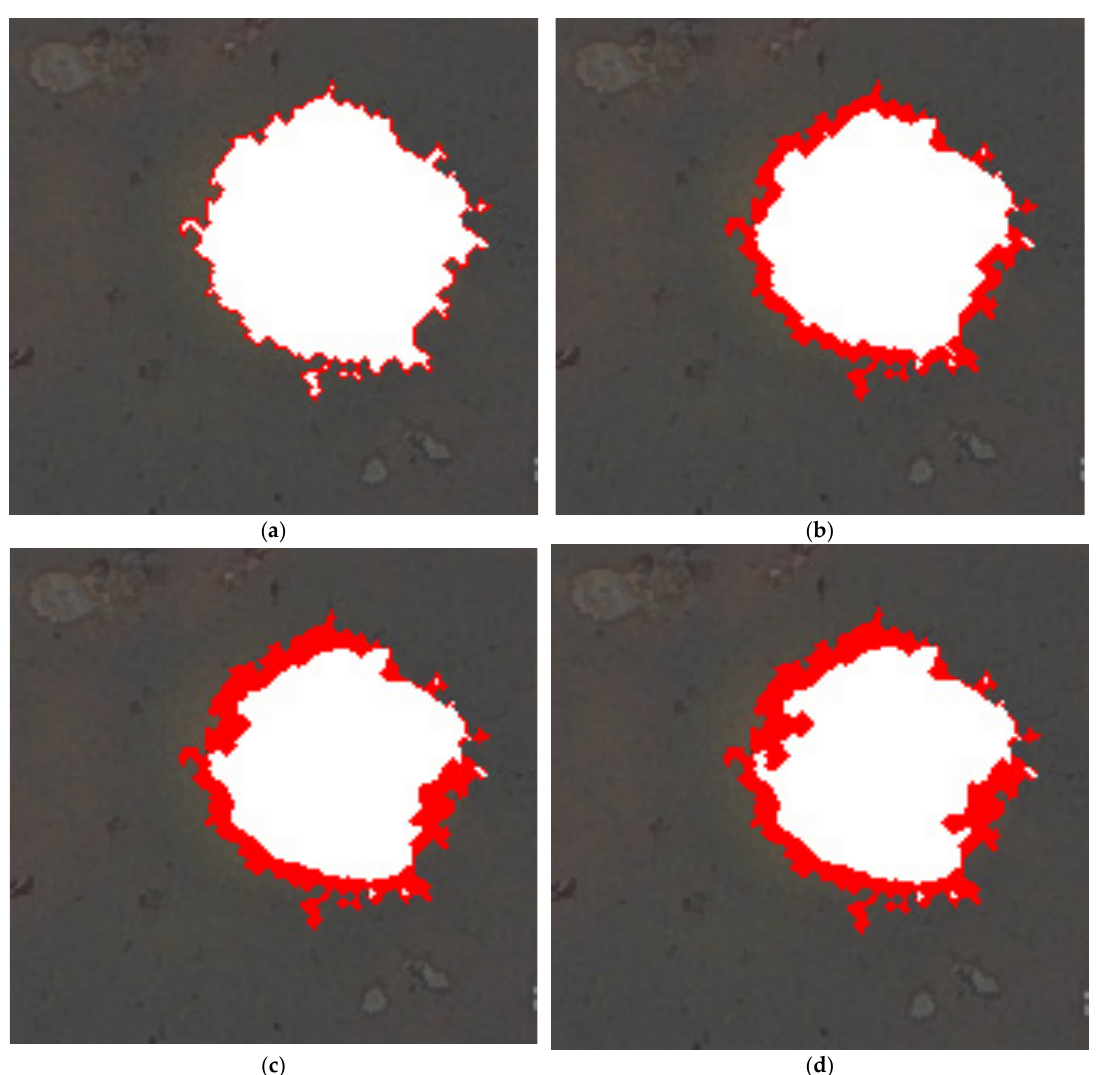
Figure 13. Results of applying different erosion limits to the particle from Figure 11a: ( a ) 1; ( b ) 5; ( c ) 10; ( d ) 15. Red colour represents the identified particle area outline in the absence of border-based erosion.